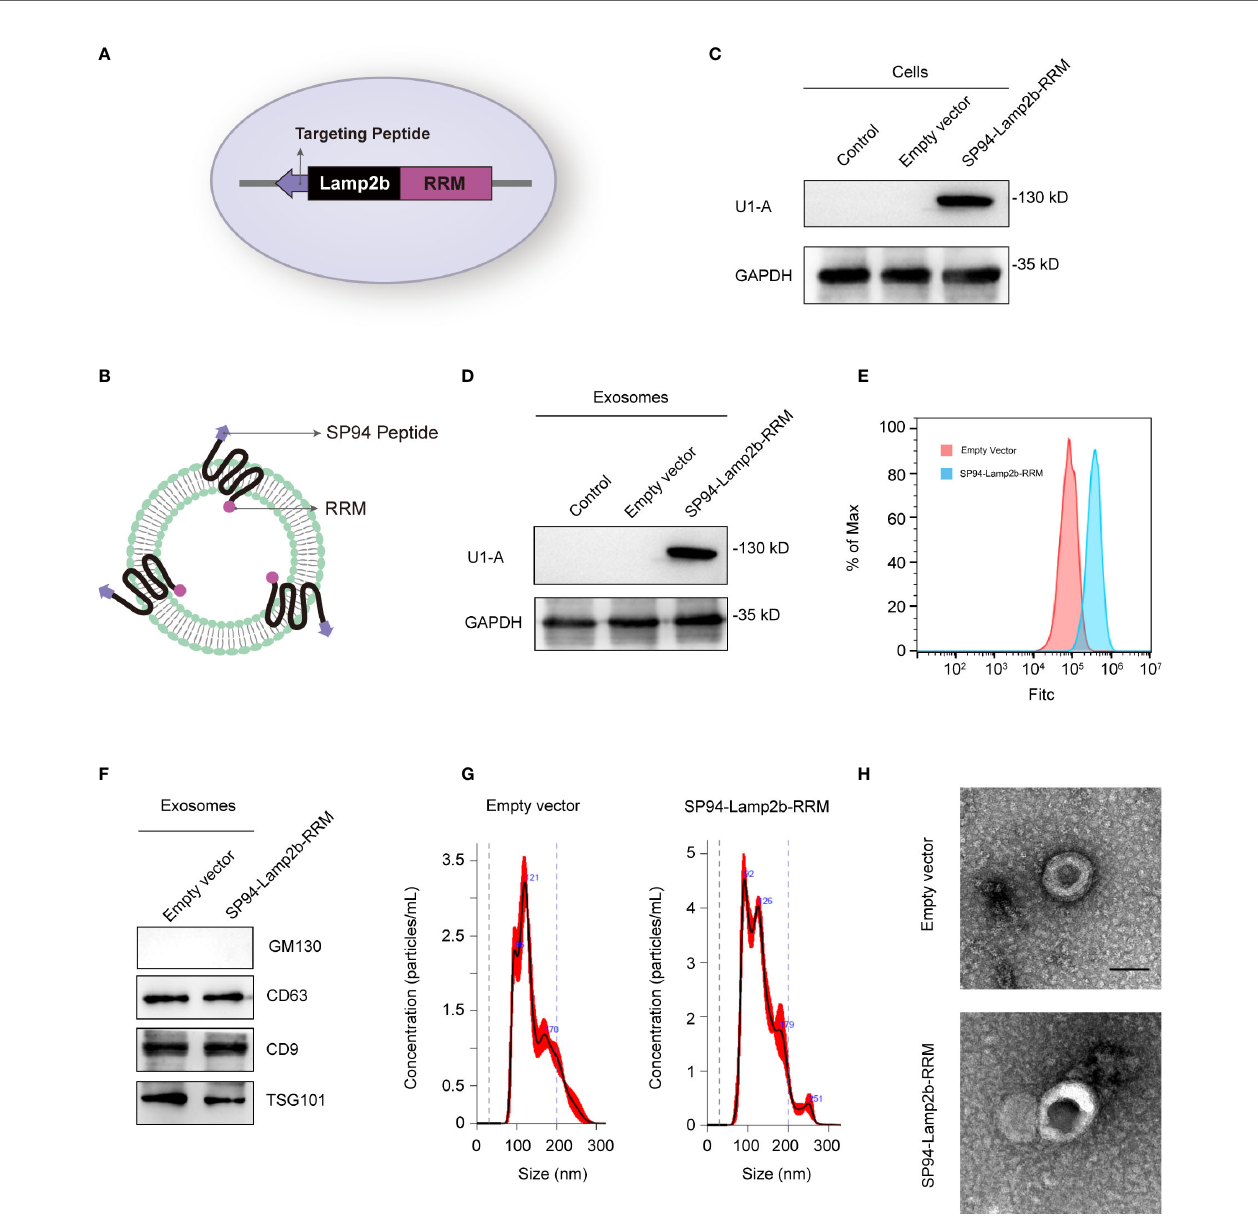
FIGURE 3 | Preparation and characterization of SP94-Lamp2b-RRM fusion protein-engineered exosomes. (A) Schematic representation of the hepatoma-cell- targeting peptide SP94 and the RRM of U1-A fused to the N-terminus and C-terminus of Lamp2b. (B) Schematic representation of the structure of the SP94- Lamp2b-RRM fusion protein and the engineered exosomes. (C) Western blot analysis of U1-A expression in HEK-293T cells transfected with empty vector or SP94- Lamp2b-RRM plasmids. (D) U1-A expression in exosomes derived from HEK-293T cells transfected with empty vector or SP94-Lamp2b-RRM plasmids. (E) Equal amount of DiO-labeled exosomes were incubated with 1*10 6 immobilized HepG-2 cells for 1h. After washing, unbound exosomes were removed. HepG-2 cells were used for fl ow cytometry after trypsinization. The binding of different exosomes to HepG-2 cells was then quantitated by fl ow cytometry (FITC channel). (F) Western blot analysis of the exosome markers CD63, CD9 and TSG101, and the exclusive exosome marker GM130 on exosomes derived from HEK-293T cells transfected with different plasmids. (G) Nanoparticle tracking analysis shows the size distribution of exosomes derived from HEK-293T cells transfected with different plasmids. (H) Representative TEM images of exosomes derived from control or SP94-Lamp2b-RRM plasmid-transfected HEK-293T cells (scale bar, 100